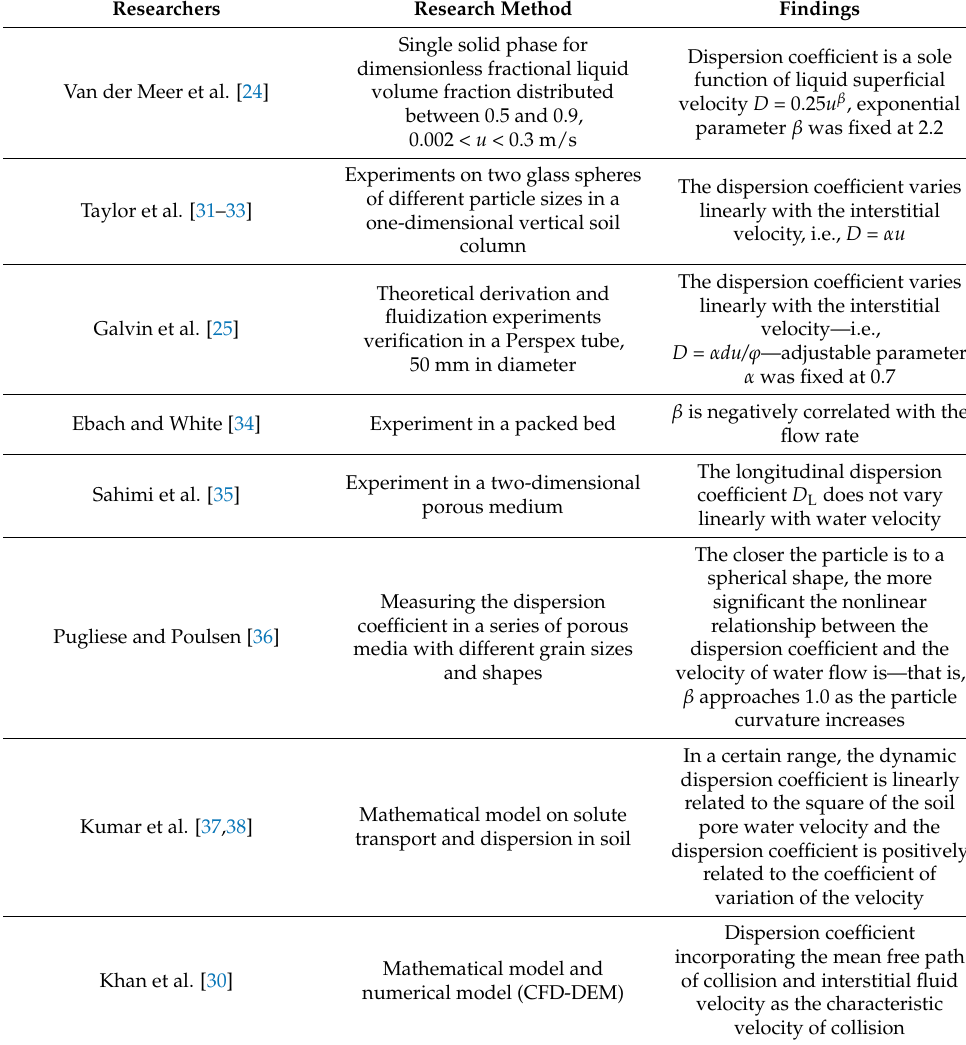
Table 1. Main research findings on the relationship between the dispersion coefficient, structure of porous media, and fluid